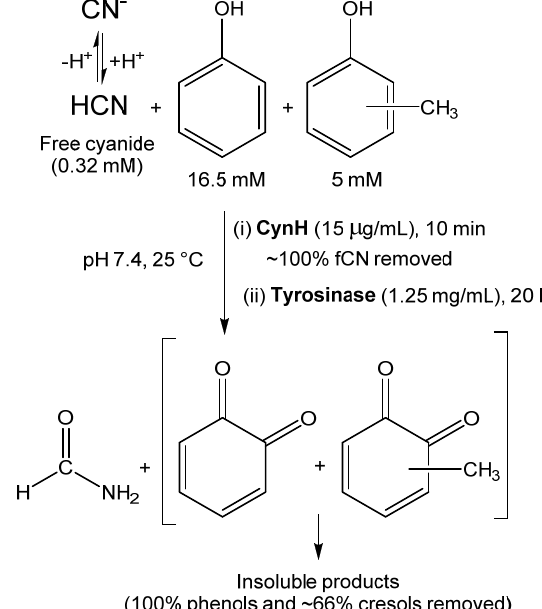
Figure 6. Removal of free cyanide (fCN) and phenol compounds (phenol, m -cresol, and p -cresol) from coking wastewater by cyanide hydratase (CynH) and tyrosinase, respectively. The reactions cannot proceed simultaneously due to the inhibition of tyrosinase (a copper enzyme) by fCN. Therefore, in the first step, fCN was converted to formamide by CynH overproduced in Escherichia coli and purified. In the second step, phenol compounds were degraded by the tyrosinase extracted from the fruiting bodies of Agaricus bisporus . Formamide, unlike fCN, was not inhibitory to tyrosinase [61].